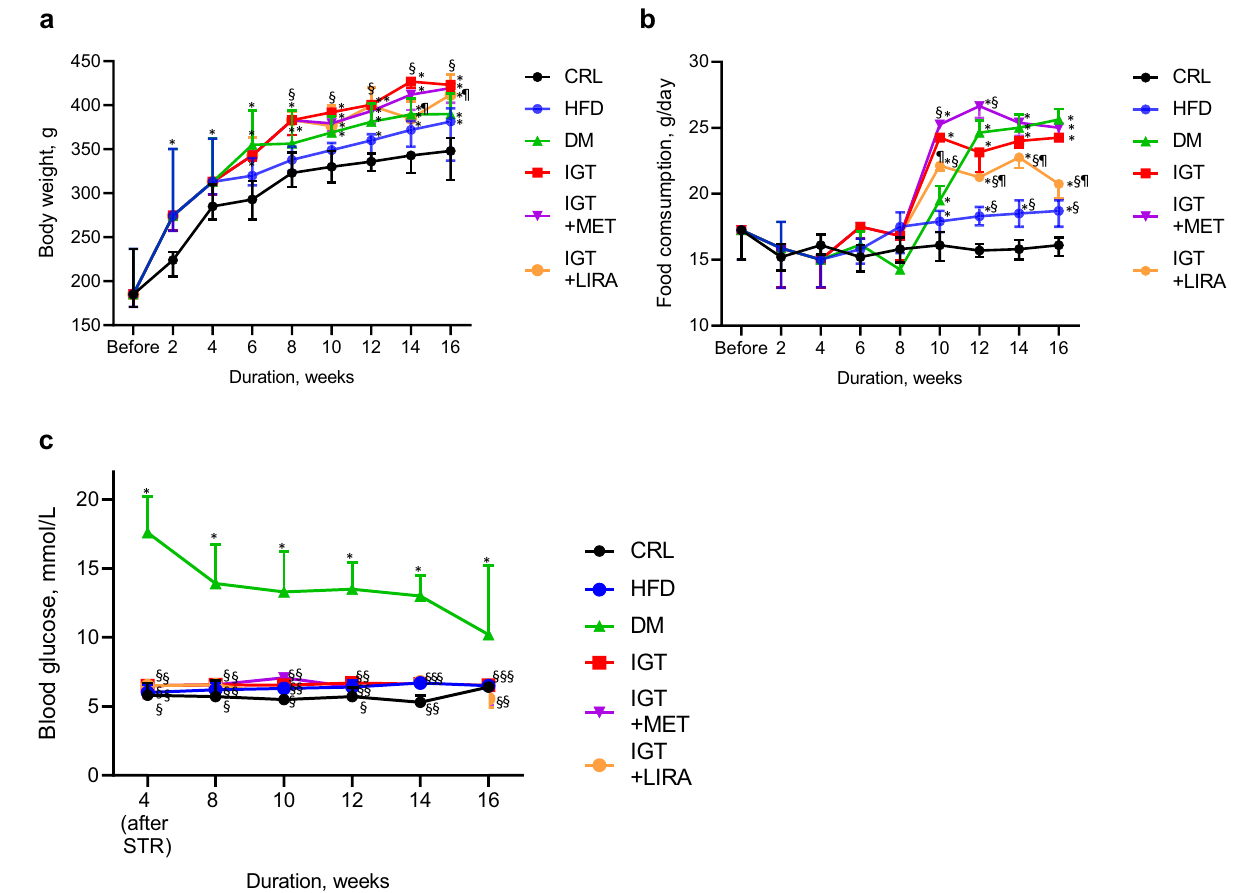
Figure 2. Dynamics in body weight, food consumption and glycemia during the experiment. ( a ) body weight, ( b ) food consumption, ( c ) blood glucose dynamics. Results are presented as median (25; 75) %. CRL (n = 6), control group; HFD (n = 8), high-fat diet group; DM (n = 4), type 2 diabetes mellitus group; IGT (n = 4), impaired glucose tolerance group; IGT + MET (n = 4), impaired glucose tolerance + metformin group; IGT + LIRA (n = 4), impaired glucose tolerance + liraglutide group. * p < 0.05, comparing with CRL group. § p < 0.05, comparing with DM group. ¶< 0.05, while comparing between groups IGT + MET and IGT + LIRA. STR,